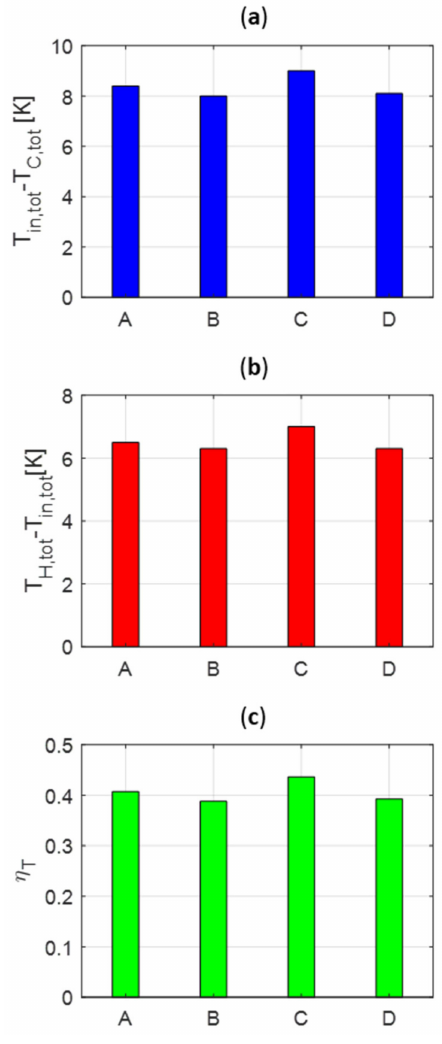
Figure 7. Predicted temperature separations at ( a ) cold outlet and ( b ) hot outlet. ( c ) Isentropic temperature